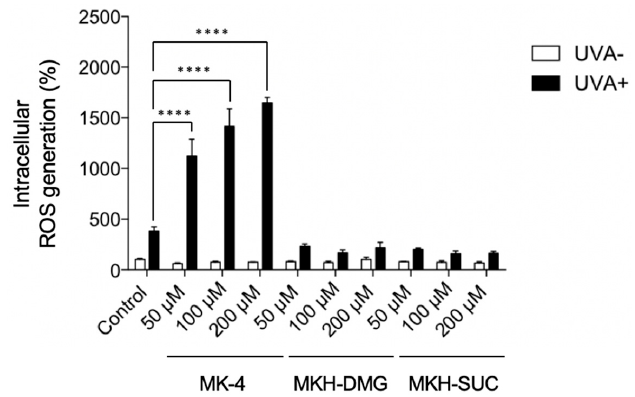
Figure 5. Intracellular ROS generation in HaCaT cells treated with MK-4 and MKH-ester derivatives and irradiated with UVA. HaCaT cells were treated with MK-4, MKH-DMG, or MKH-SUC in the presence or absence of UVA irradiation (15 J / cm 2 ). Intracellular ROS generation was measured using a